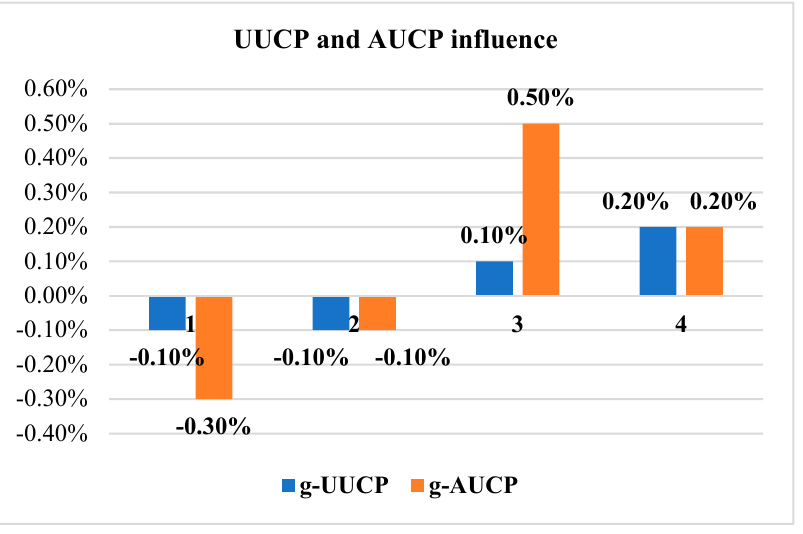
A graphical representation of the dependent input values of UUCP and AUCP with the values of their errors is given in Figure 9.